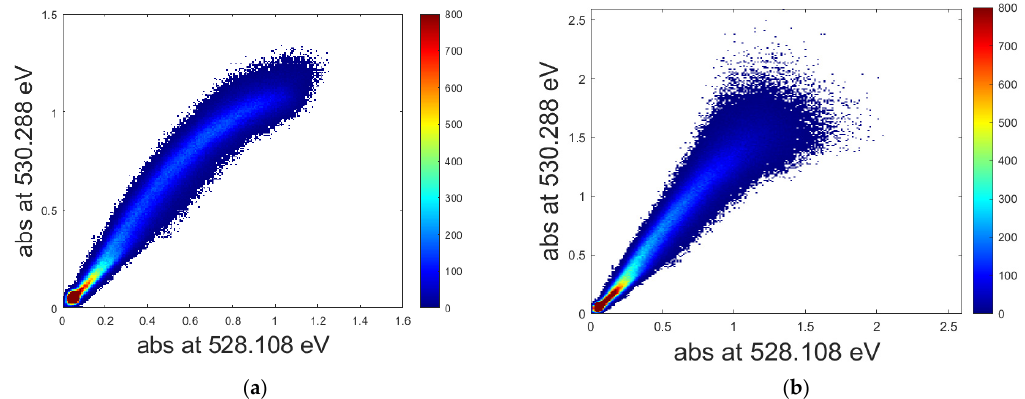
Figure A3. Effect of the background correction on the phase map for P05 data where the absorbance peak value at ~530.3 eV versus the one at ~528.1 eV is plotted. ( a ) Phase map for the noncorrected spectrum and ( b ) for the background corrected one. In ( b ) plot values are redistributed on an almost straight line and on a bigger absorbance values range.